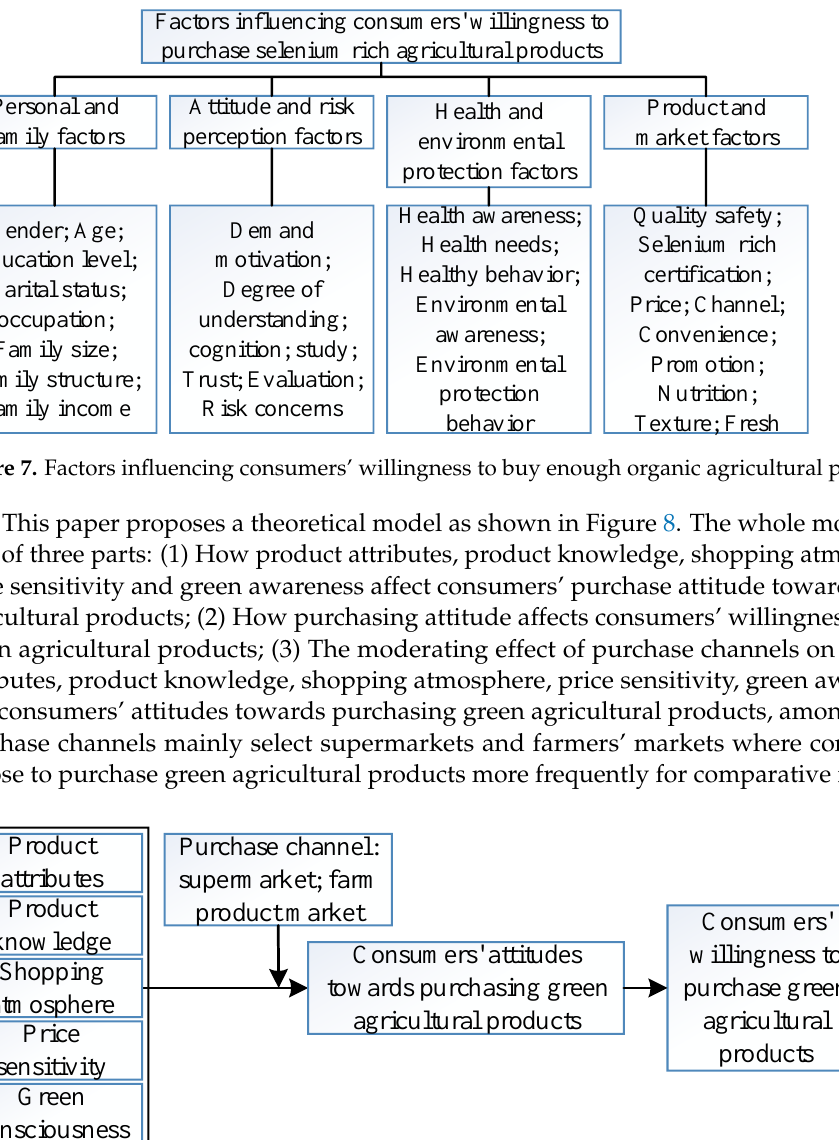
Figure 8. Theoretical Model.